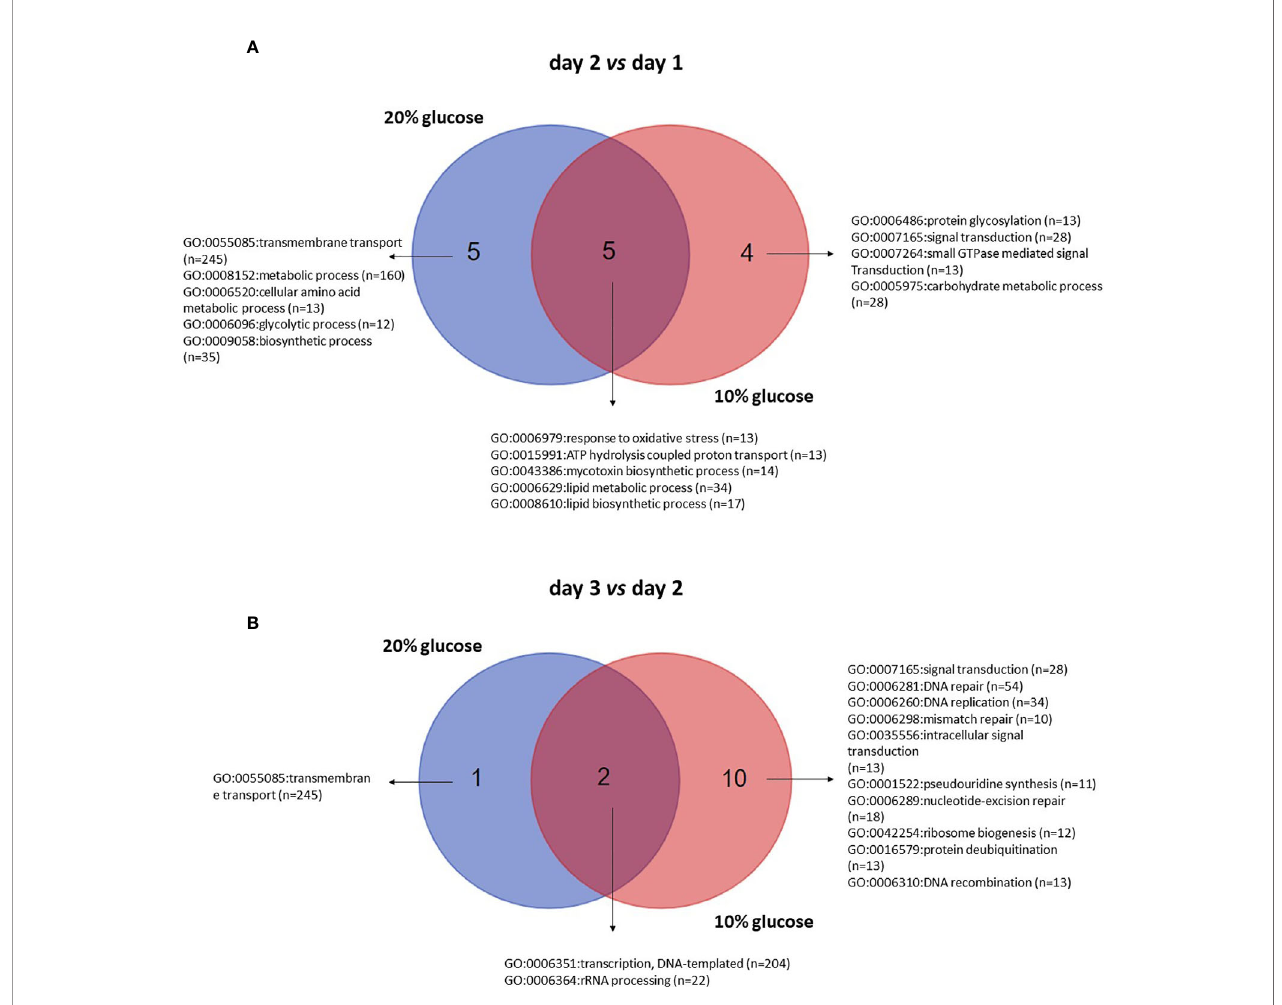
FIGURE 6 | Venn diagram of enriched gene ontology (GO) terms for biological processes of blastospores of B. bassiana produced in medium amended with 20% or 10% glucose comparing day 2 with day 1 (A) and day 3 with day 2 (B) within each glucose concentration tested. FDR p < 0.25 (see also Supplemental Table S4